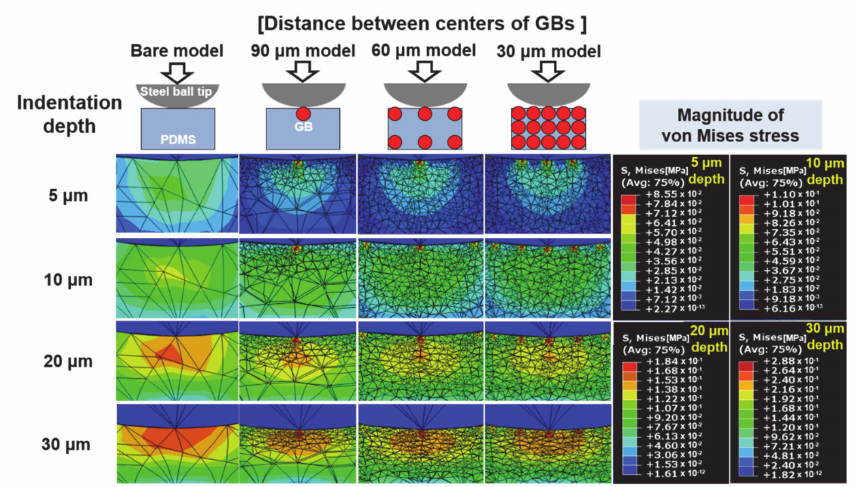
Figure 4. FEA simulation models and results according to the indentation depths for 5, 10, 20, 30 µ m and the ball distances for 30, 60, 90 µ m. The scale indicates the magnitude of von Mises